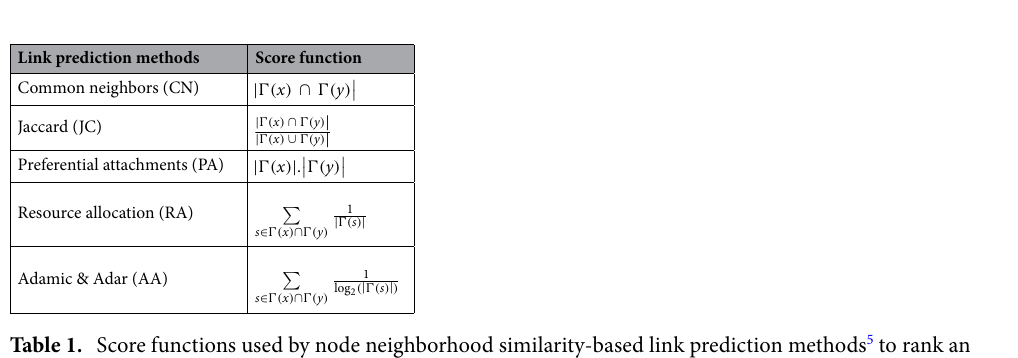
Table 1. Score functions used by node neighborhood similarity-based link prediction methods 5 to rank an edge confined to x and y nodes in RLP